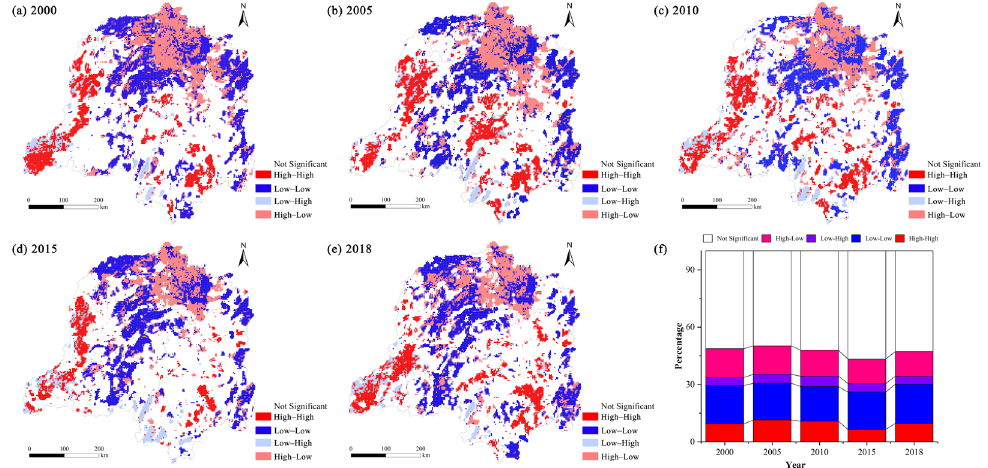
Figure 4. Local spatial autocorrelation between spatial conflict and soil erosion in the Dongting Lake Basin from 2000 to 2018: ( a – e ) local spatial correlation distribution, and ( f ) mode percentages.